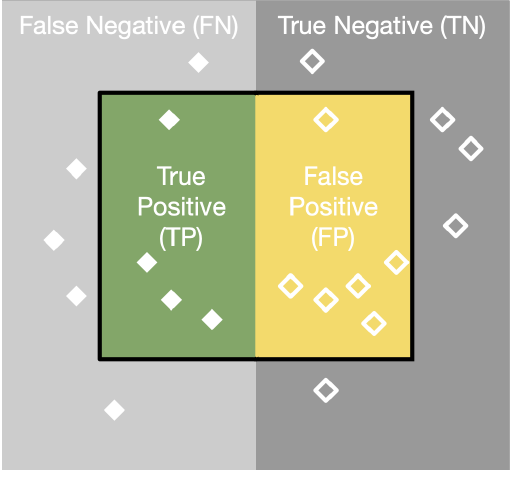
Figure 4. Description of Precision and